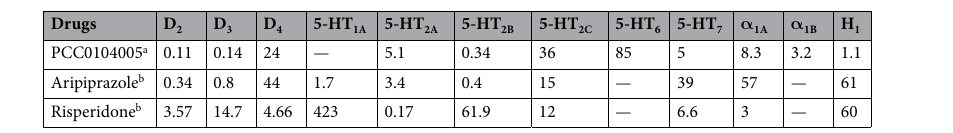
Table 1. Receptor binding affinity of PCC0104005, as measured by radioligand displacement assays: comparison with antipsychotic medications. a PCC0104005 affinities were determined as described in the “ Materials and Methods ” section. b Binding affinities for other compounds were derived from